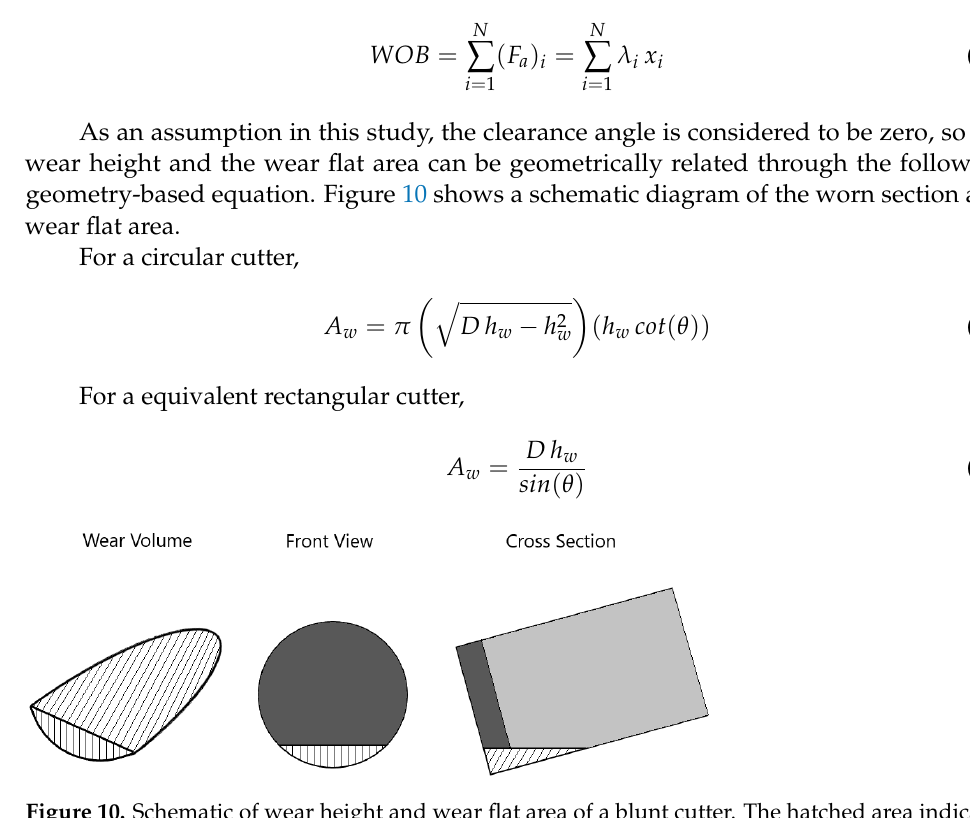
Figure 10. Schematic of wear height and wear flat area of a blunt cutter. The hatched area indicates the worn section of the